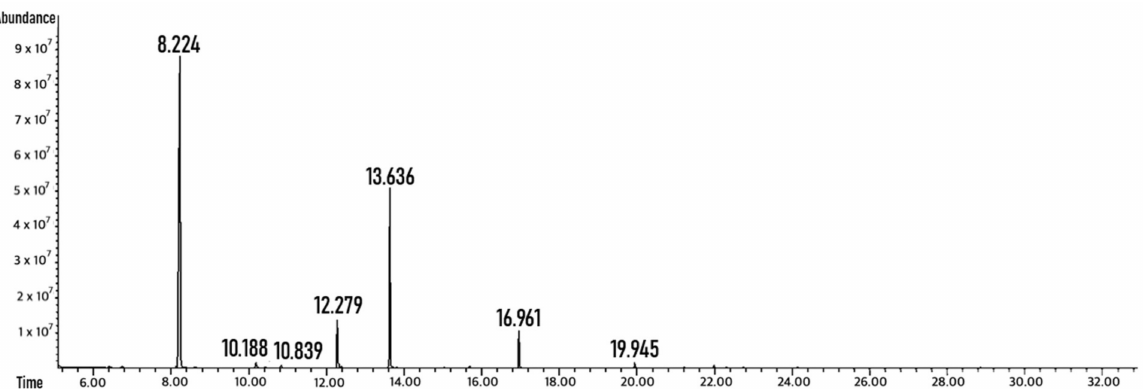
Figure 3. Probiotic consortium secondary metabolites analysis by GC-MSD after growth on Maitake extract. The figure represents the chromatogram obtained after GC-MSD analysis. The probiotic consortium was incubated for 48 h on Maitake extract at a concentration of 2% w / v . The cultural broth was extracted and then analyzed in GC-MSD. The intermediate metabolites identified are reported in the